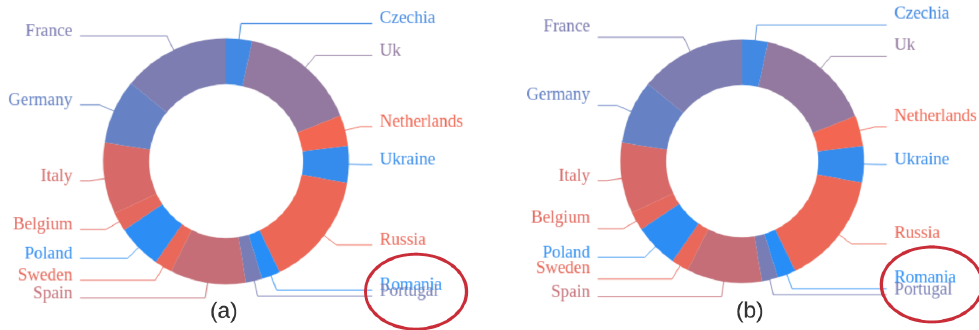
Figure 8. Example of 1D algorithm overlap reduction: ( a ) before use; ( b ) after